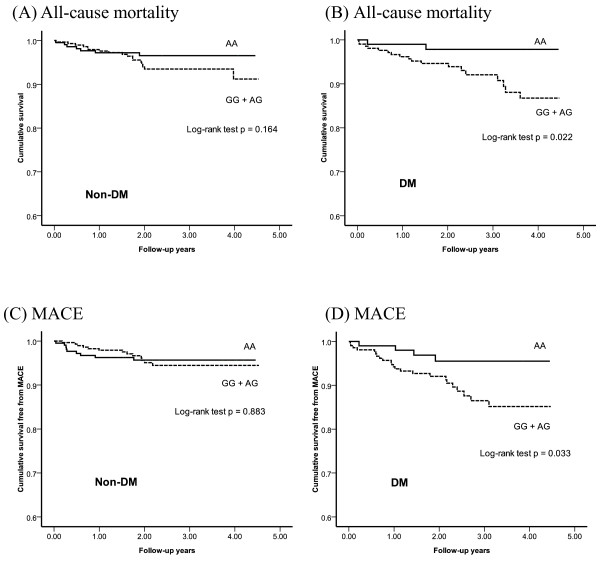
Kaplan-Meier survival analyses with all-cause mortality (A, B) and major adverse cardiovascular events (MACE) (C, D) during follow-up according to the genotype of rs1241321 (AA___ vs. GG + AG....) in diabetic and non-diabetic groups. P values by log-rank test were shown.